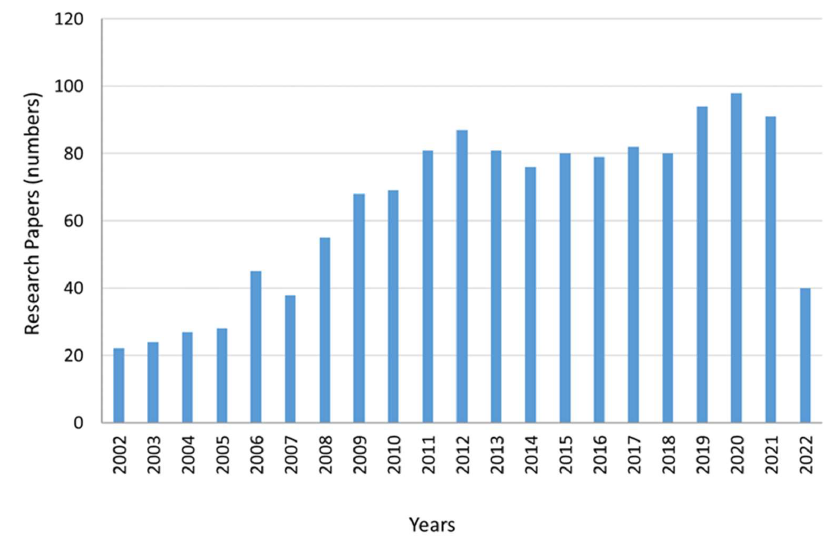
Figure 3. Annual Article Frequency on GRACE.